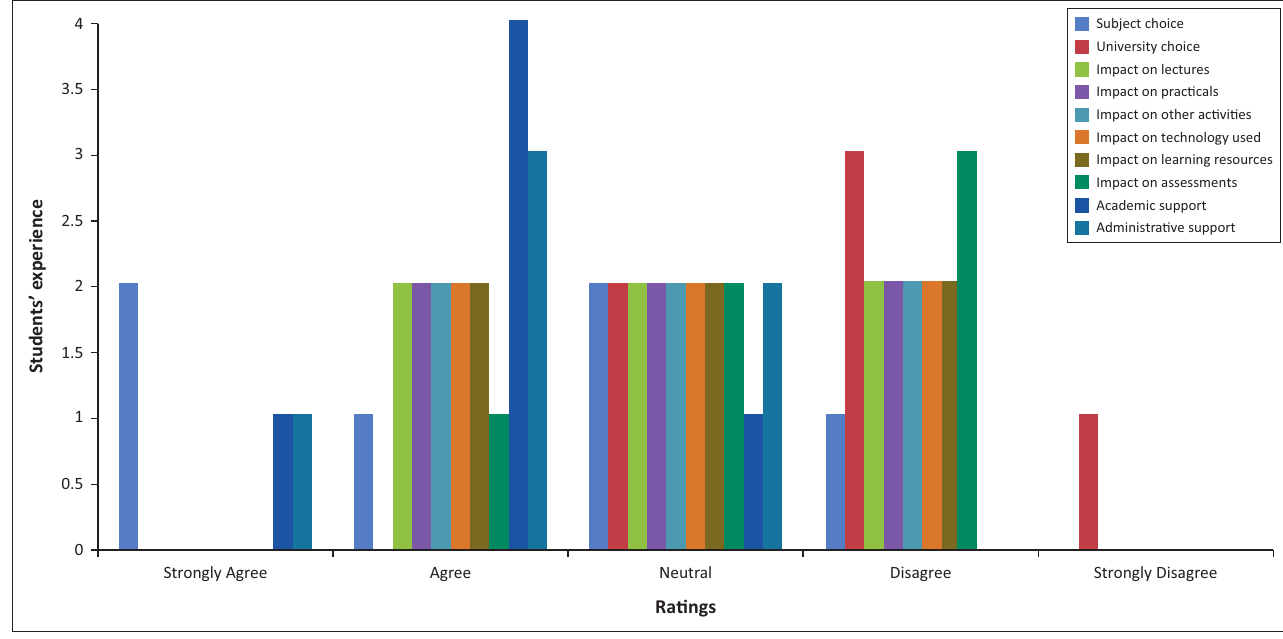
FIGURE 5: Views of students with disabilities about their university